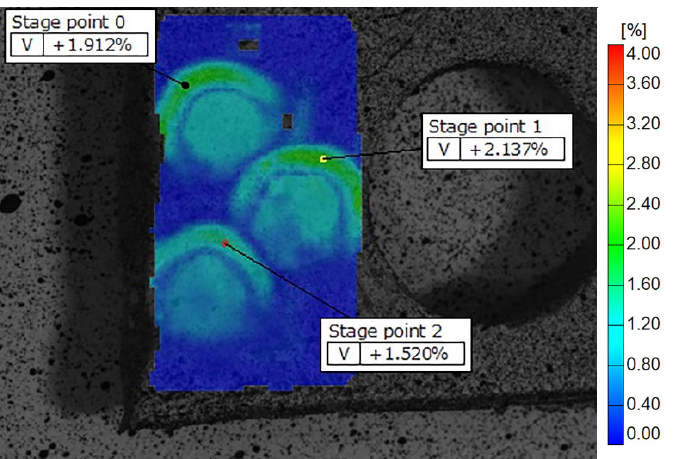
Figure 7. Display of Biodentine deformation fields across the samples on Teflon discs, showing peripheral zones with higher and central zones with lower strain values. The color scale indicates different strain values, with the highest marked in red and orange. Some of the recorded reference points are shown as stage points 0, 1 and 2.